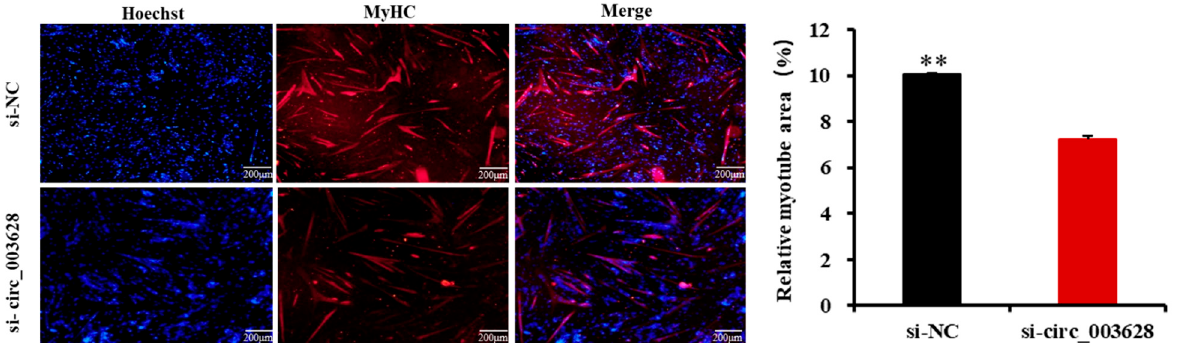
Figure 8. The effect of circ_003628 on area of MyHC-labeled positive myotubes detected using cell immunofluorescence. Scale bar indicates 200 μ m. ** p < 0.01. immunofluorescence. Scale bar indicates 200 µ m. ** p <